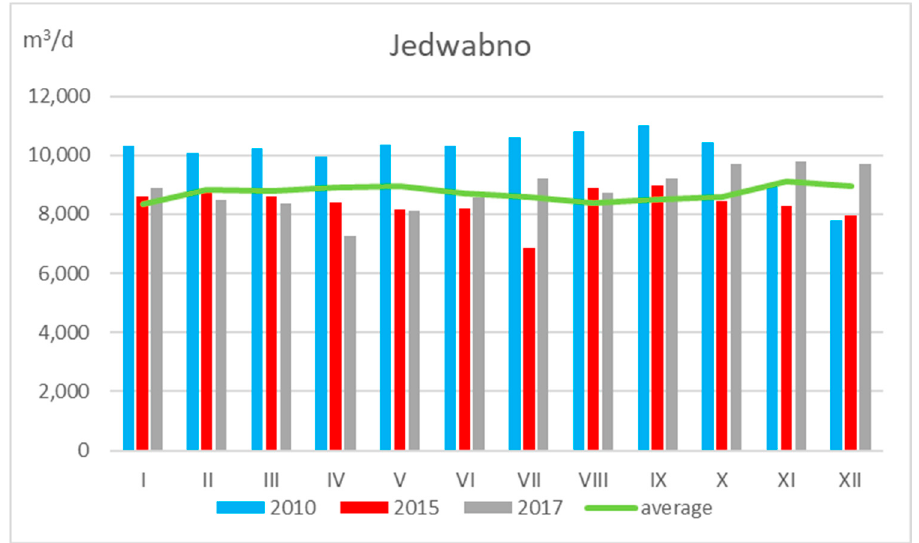
Figure 14. Monthly water abstraction level measured in m 3 /d from the infiltration intake in Jed- wabno, shown for wet (2010), dry (2015), and average (2017) years.